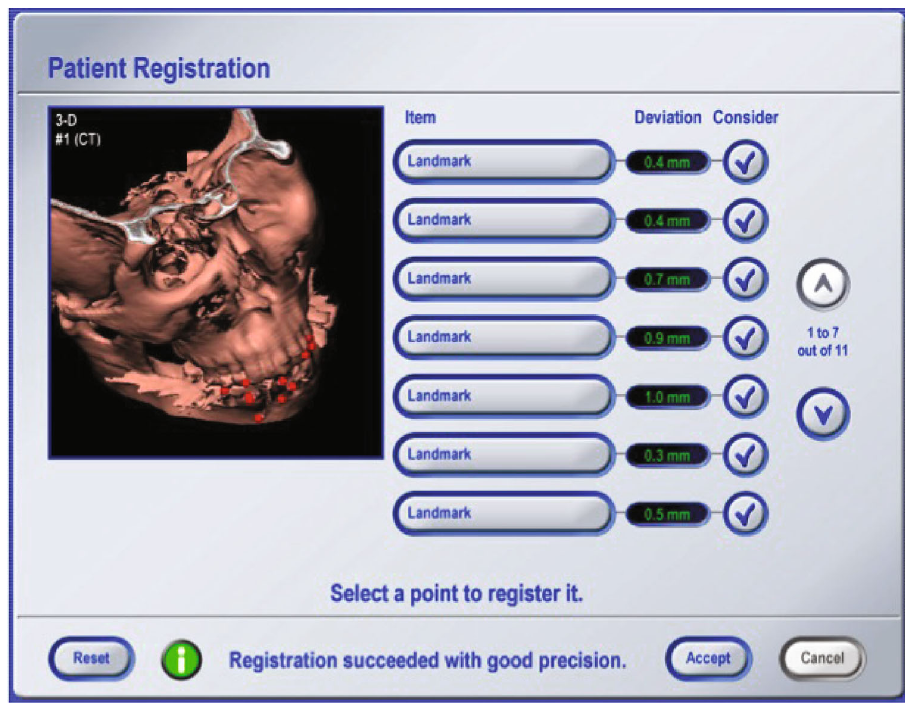
Figure 7: Screenshot of the navigation system during registration. The red points indicate the numbered landmarks (gutta-percha markers in the splint) for the marker-based pair-point registration. Deviations of each landmark are less than 1.0 mm.